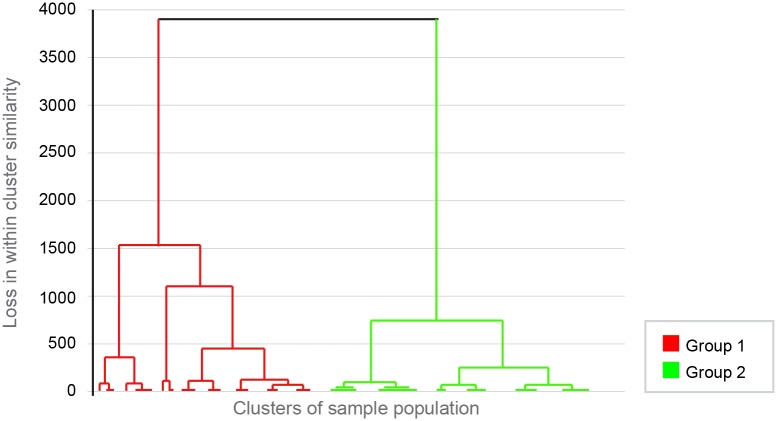
Dendrogram plot generated from the hierarchical cluster analysis of Principal Component analysis of MDORS results of the population study: Clusters distribution.This dendrogram represents the result of the HCA (Hierarchical cluster analysis). The plot shows the distribution of the sample population in different clusters. The sample population appears principally distributed in two groups (two big clusters) after PCA-HCA: Group I (higher emotional dog-owner bond) and Group II (lower emotional dog-owner bond). The vertical axis indicates the loss in within cluster similarity (i.e. the variance increase, when clusters are merged). The horizontal axis represents the cluster groups of all the individuals of the sample population.